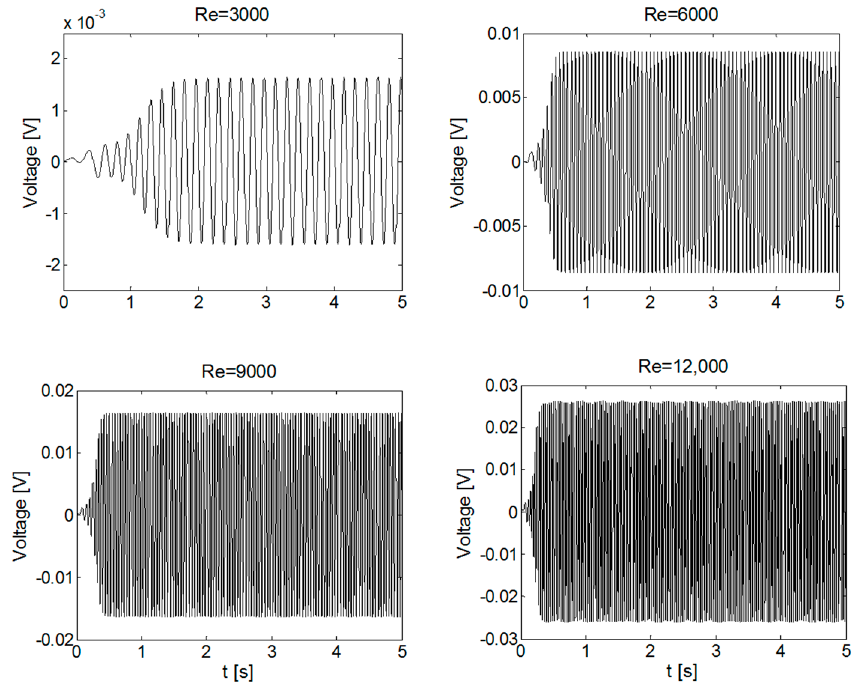
Figure 10. Output voltage for each case at different Reynolds numbers.